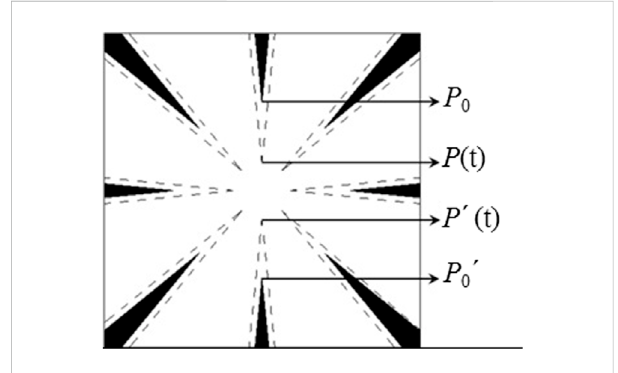
FIGURE 4 Schematic diagram of image displacement